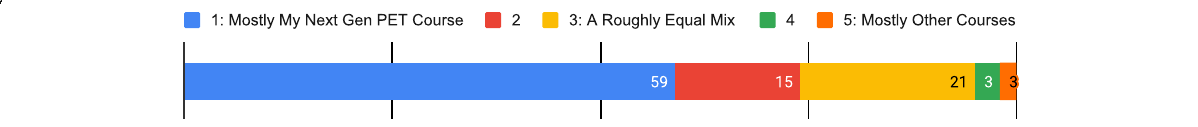
Fig. 9 Courses impacted by participation in the FOLC. The effect of FOLC participation on the range of courses members teach. Respondents indicated if the FOLC impacted mostly their teaching of the Next Gen PET course, mostly the other courses they teach, or a mix of both. Numbers superimposed on the bar are the percentage of respondents choosing that option. N = 39